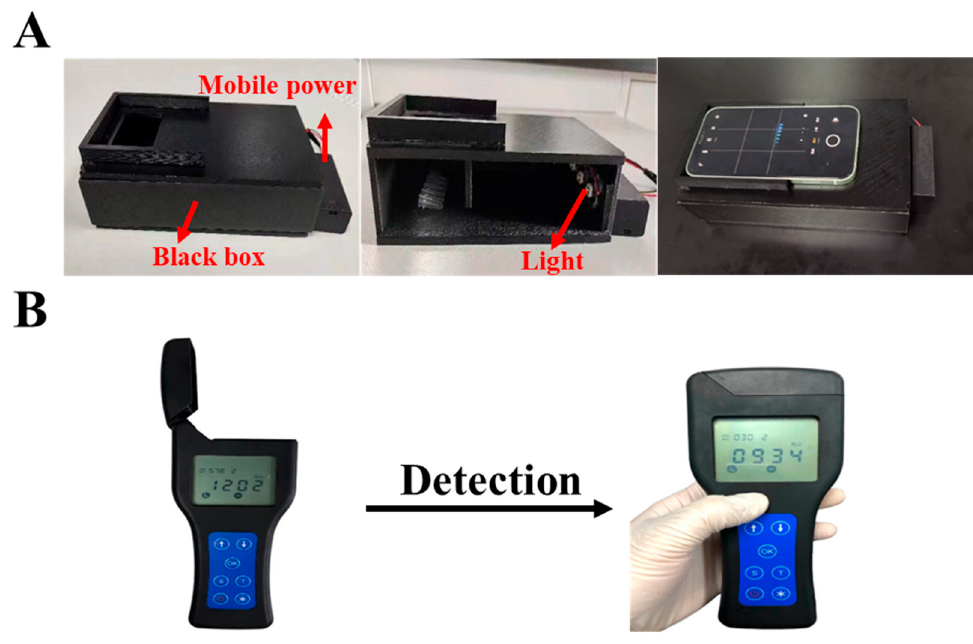
Figure 6. ( A ) The configuration of self-made FL detector. ( B ) The portable ATP bioluminescent meter.